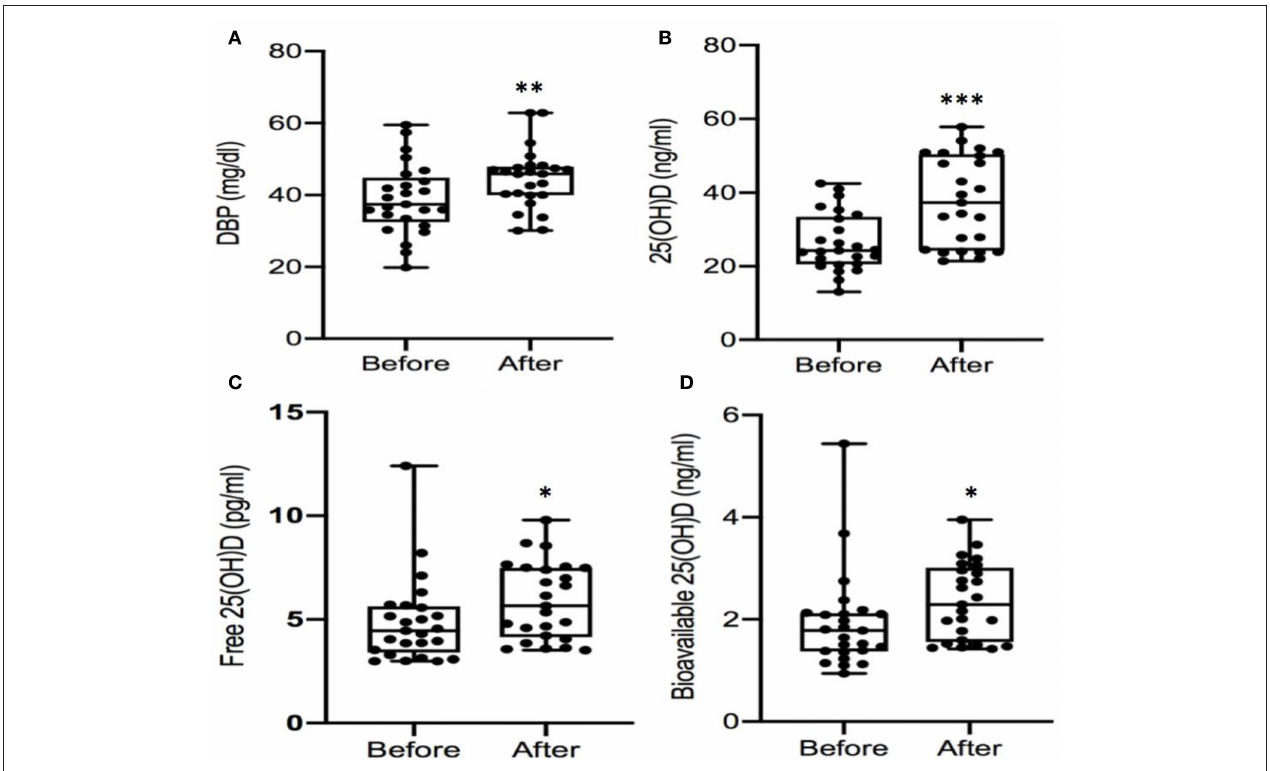
FIGURE 2 | (A-D) Comparison of serum levels of DBP and 25(OH)D before and after parathyroidectomy. DBP, vitamin D binding protein; 25OHD, 25-hydroxyvitamin D. * P < 0.05; ** P < 0.01; *** P <